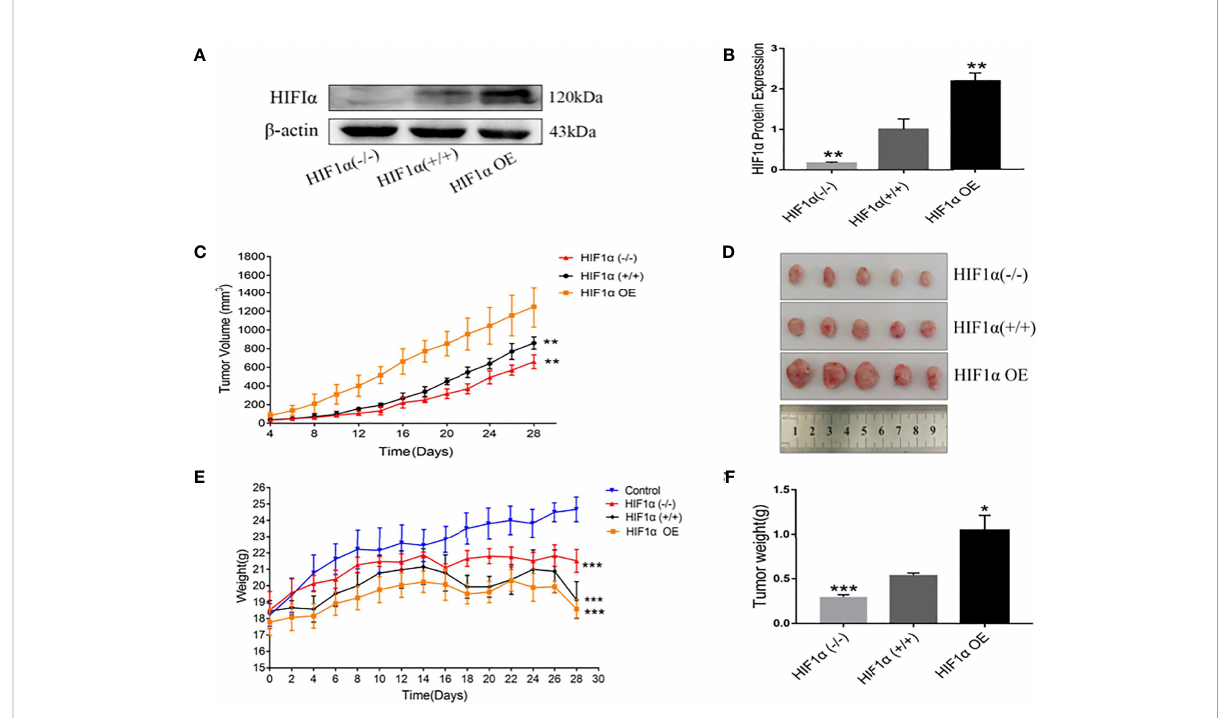
FIGURE 2 Upregulation of HIF1 can promote tumor growth. (A) Detection of HIF1 protein expression in tumor-bearing mice after construction of xenograft model. (B) Quantitative data of (A) . HIF1 a (-/-) group, HIF1 a OE group, ** P < 0.01 vs . HIF1 a (+/+) group. (C) Tumor volume changes in tumor- bearing mice during feeding (n =5). HIF1 a (-/-) group, HIF1 a OE group, ** P < 0.01 vs . HIF1 a (+/+) group. (D) Picture of xenograft tumor. (E) Changes in body weight of tumor-bearing mice during rearing. HIF1a group, ***P<0.001 compared with the control group. (F) Tumor tissue was dissected and weighed after four weeks of feeding. HIF1a (-/-) group, ***P < 0.001 vs. HIF1a (+/+) group; HIF1a OE group, *P < 0.5 vs. HIF1a (+/+)